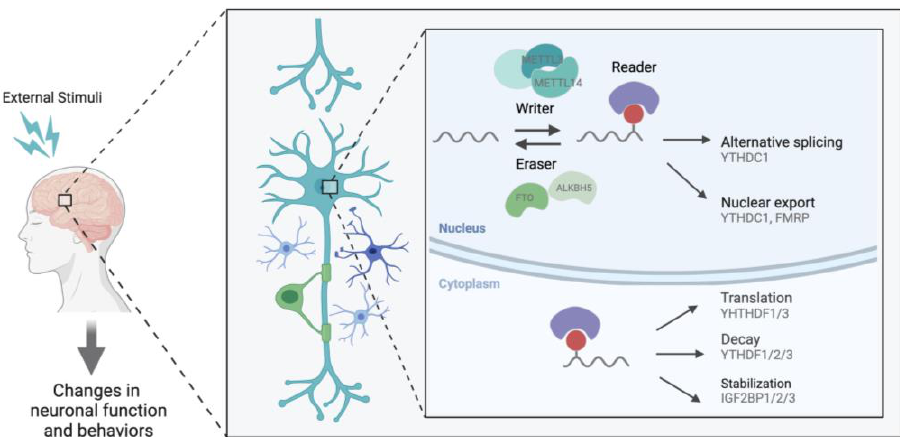
Figure 1. The suggested regulation of transcript by m6A in the nervous system. m6A is catalyzed by a writer complex consisting of METTL3, METTL14, WTAP, RBM15/15B, ZC3H13, VRMA, and HAKAI. m6A is demethylated by FTO or ALKBH5. m6A regulates the variety of mRNA metabolism in the nucleus and cytoplasm through recognition by readers, YTHDF1/2/3, YTHDC1,2, FMRP, HNRNPs, and IGFBP1/2/3. m6A has been shown to affect translation, degradation, splicing, and nuclear export and, therefore, could regulate the nervous system.